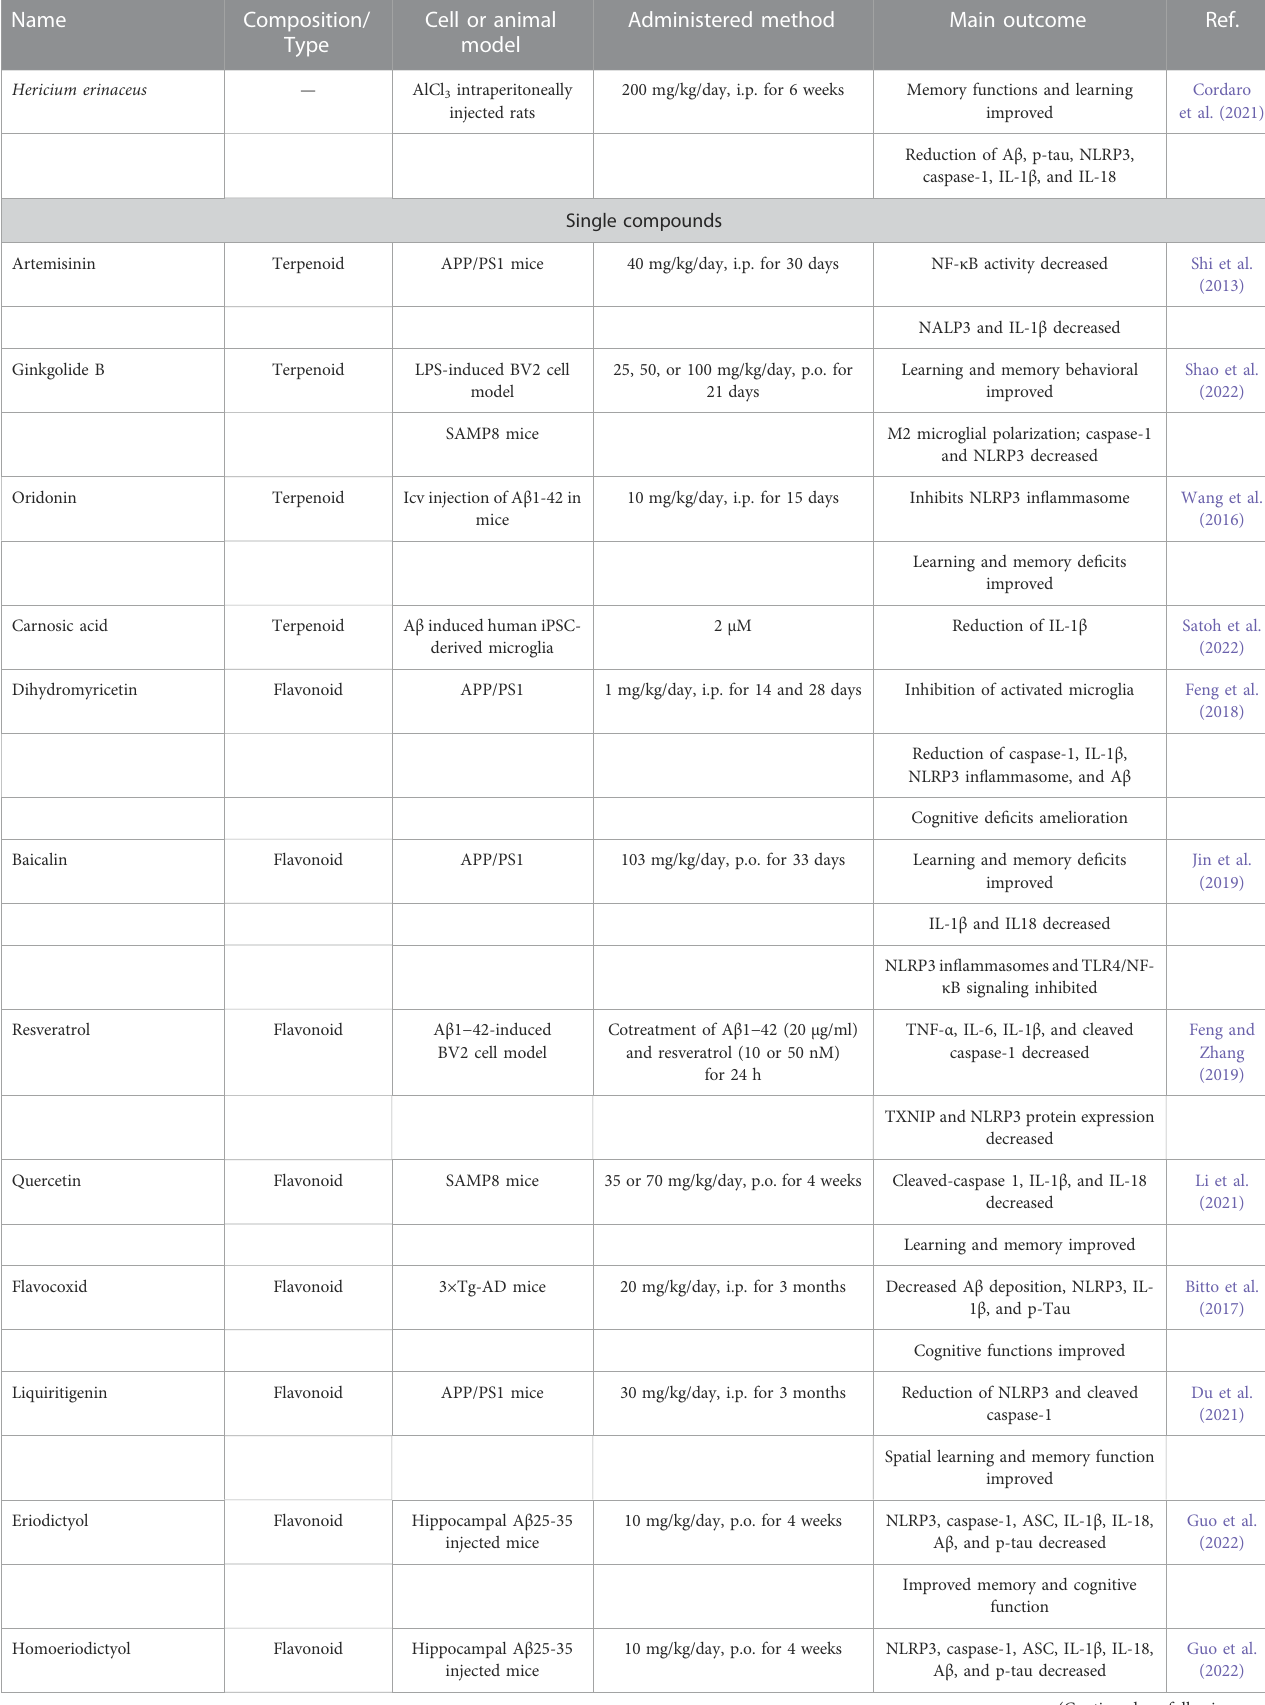
TABLE 1 ( Continued ) Formula, medicinal mixture, extracts, and natural occurring compounds for AD treatment by targeting NLRP3 in fl